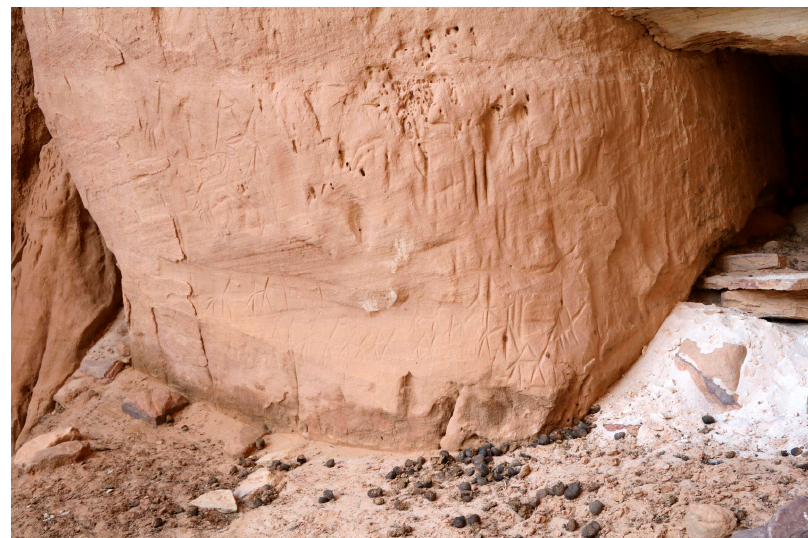
Figure 5. Engravings of camels and linear marks at the base of the rocky spur flanking the eastern side of the shelter (Photo: Mauro Colella).